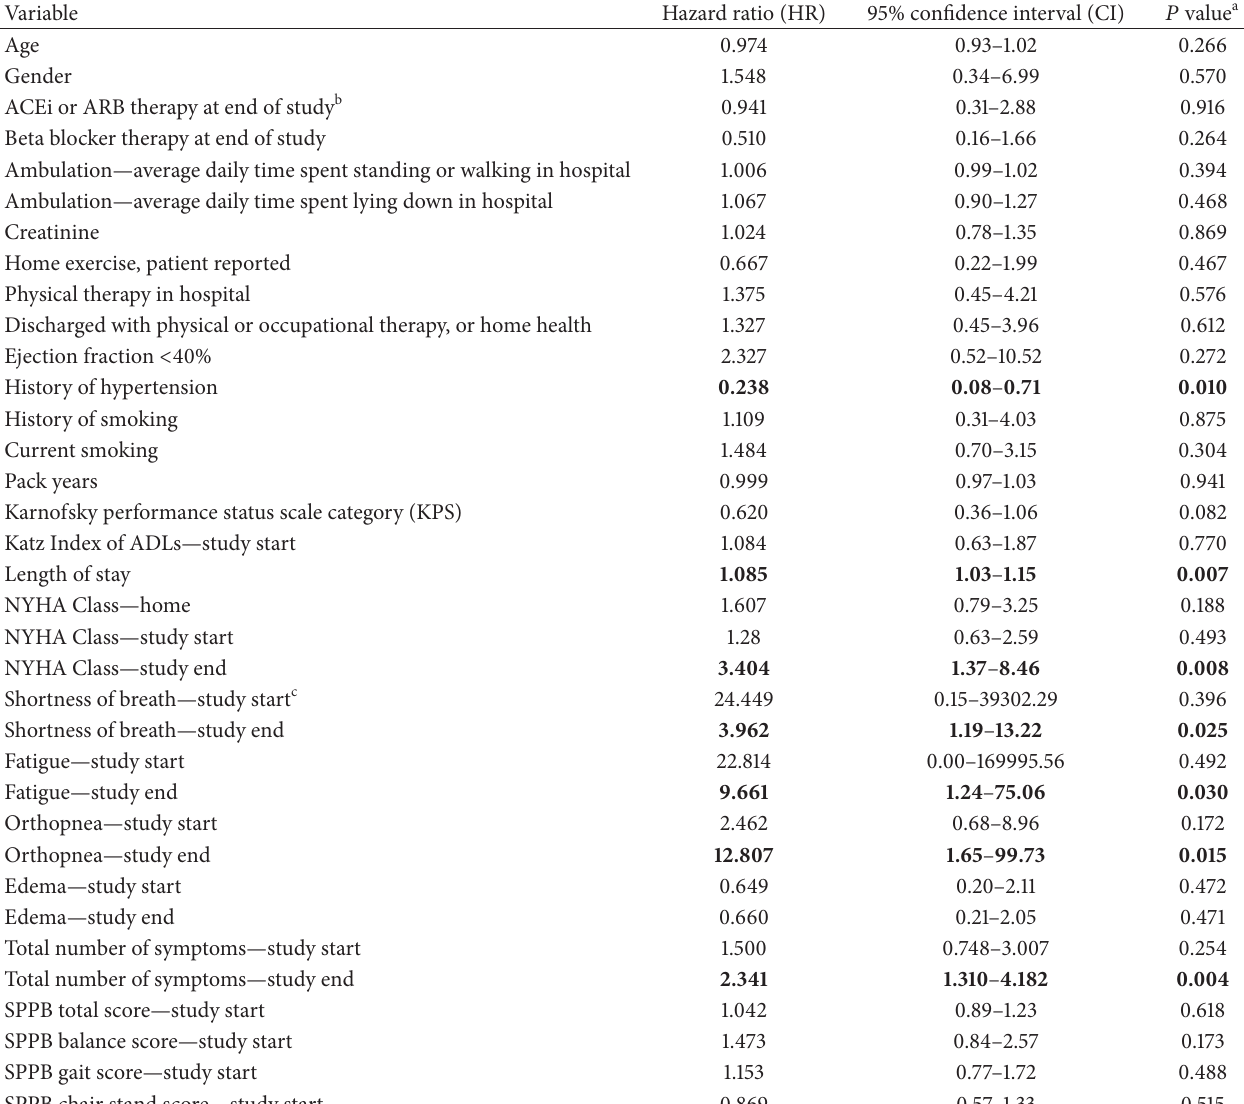
Table 6: Cox univariate predictors of cardiac events within 90 days after